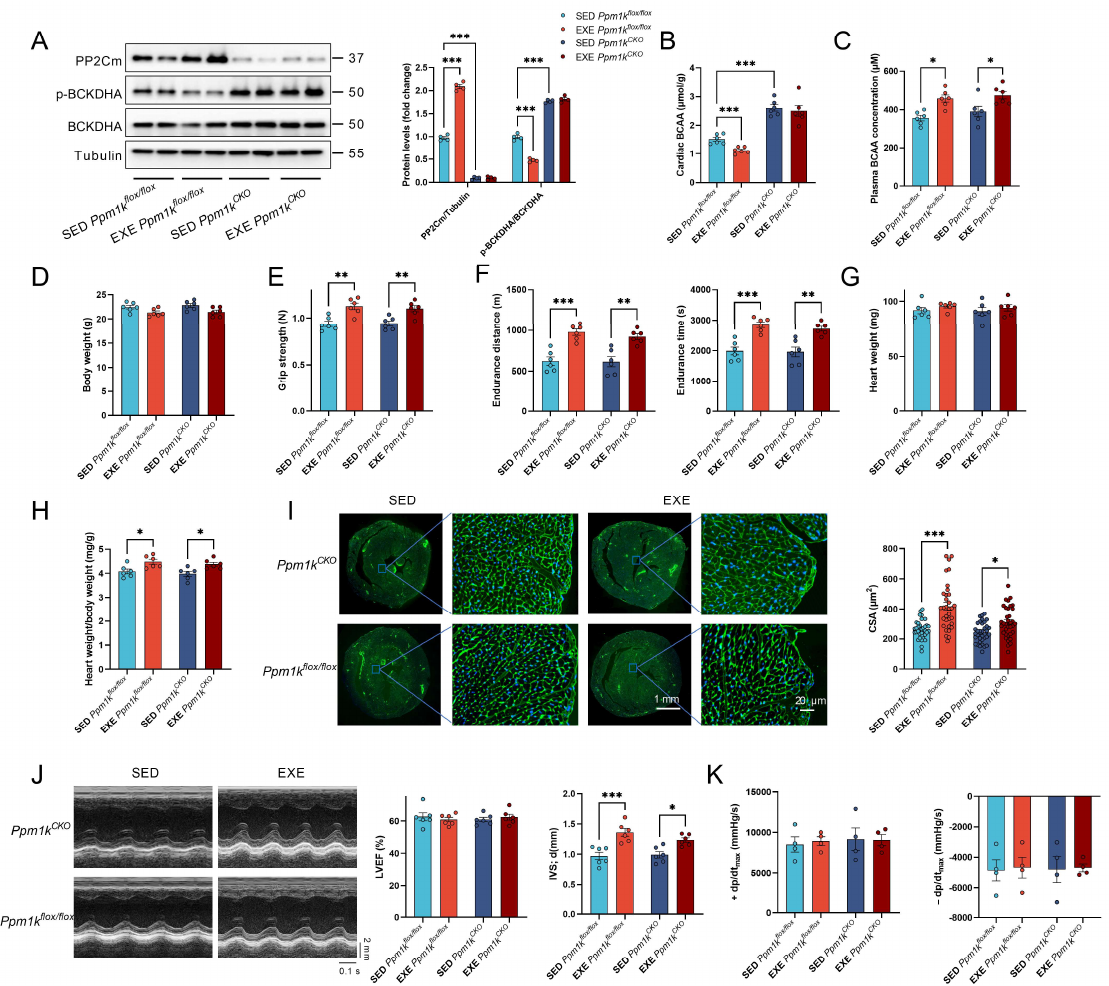
Figure 4. Cardiac-specific PP2Cm KO showed little effects on cardiac remodeling to exercise. ( A ). Ex- ercise increased the expression of PP2Cm and decreased the phosphorylation of BCKDHA in the heart from control ( Ppm1k flox/flox ) mice but not KO ( Ppm1k CKO ) mice. ( B ). Cardiac BCAA content in mice subjected to sedentary or exercise in control and KO mice. ( C ). Plasma BCAA concentrations in mice subjected to sedentary or exercise in control and KO mice. ( D ). Body weight of mice subjected to sedentary or exercise in control and KO mice. ( E , F ). Exercise increased grip strength ( E ), and treadmill performance ( F ) in both control and KO mice. ( G ). Heart weight of mice subjected to sedentary or exercise in control and KO mice. ( H ). Exercise increased the heart weight–body weight ratio in both control and KO mice. ( I ). Exercise-induced cardiac hypertrophy in both control and KO mice. Typical images of cardiac WGA staining were shown in left. Green, WGA; blue, DAPI. The quantified results of the cross-sectional area (CSA) of cardiomyocytes were shown in right. ( J ). Cardiac systolic function in mice subjected to sedentary or exercise in control and KO mice. Typical images of cardiac systolic function as detected by echocardiography were shown in left, and quantified results of ventricular ejection fraction (LVEF) and end-diastolic interventricular septal thickness (IVS; d) were shown in right. ( K ). ± dP/dt max in mice subjected to sedentary or exercise in control and KO mice ( n = 4). Values are presented as mean ± SEM. n = 6. * p < 0.05; ** p < 0.01; *** p <